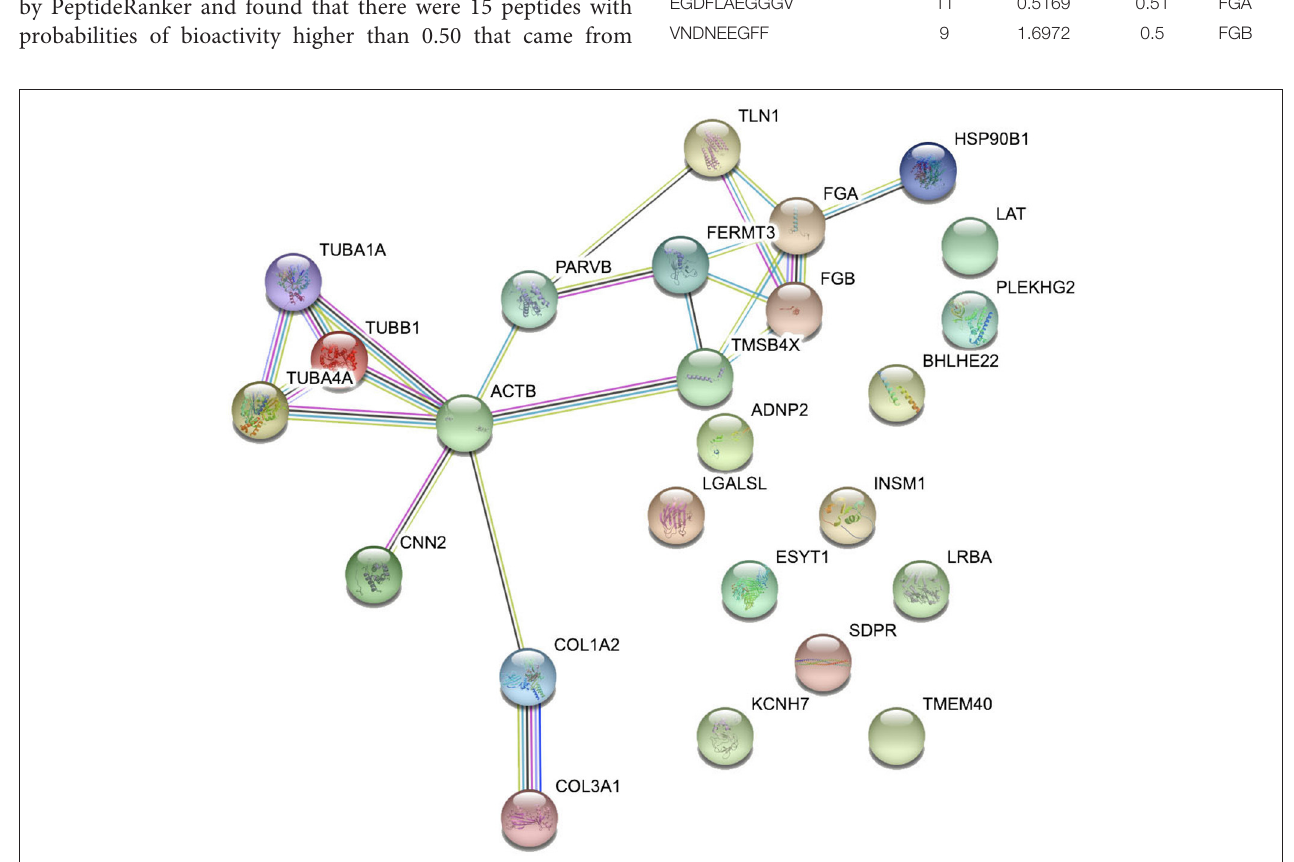
FIGURE 5 | Interaction network analysis of precursor proteins of differentially expressed peptides according to STRING.